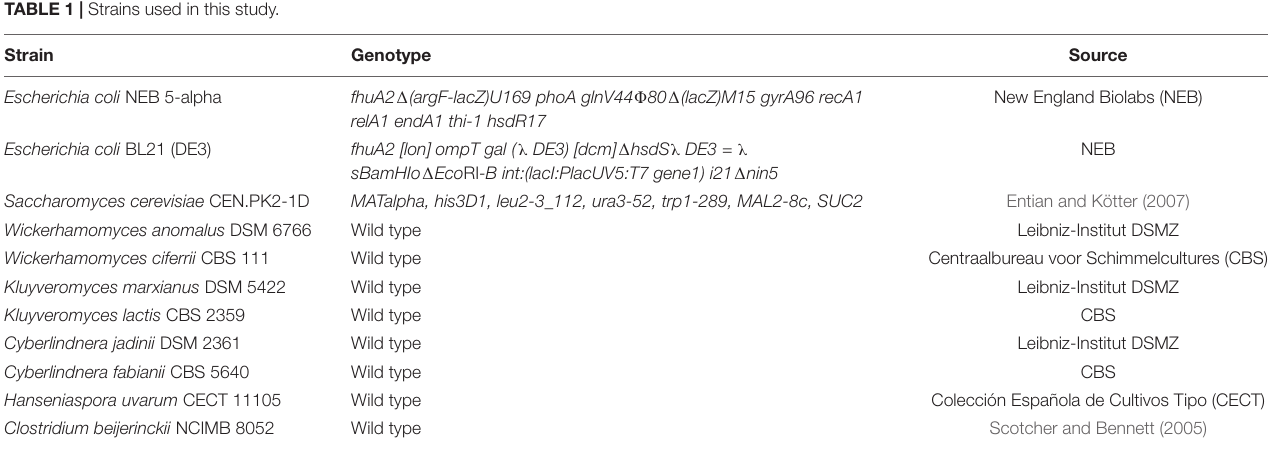
TABLE 1 | Strains used in this